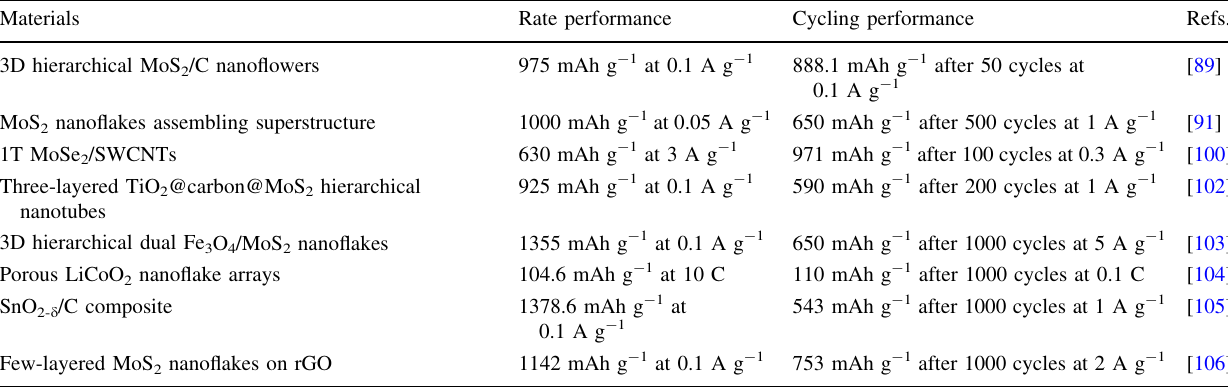
Table 2 Comparison of electrochemical performance of 2D nanoflake ensemble-based materials for lithium-ion batteries